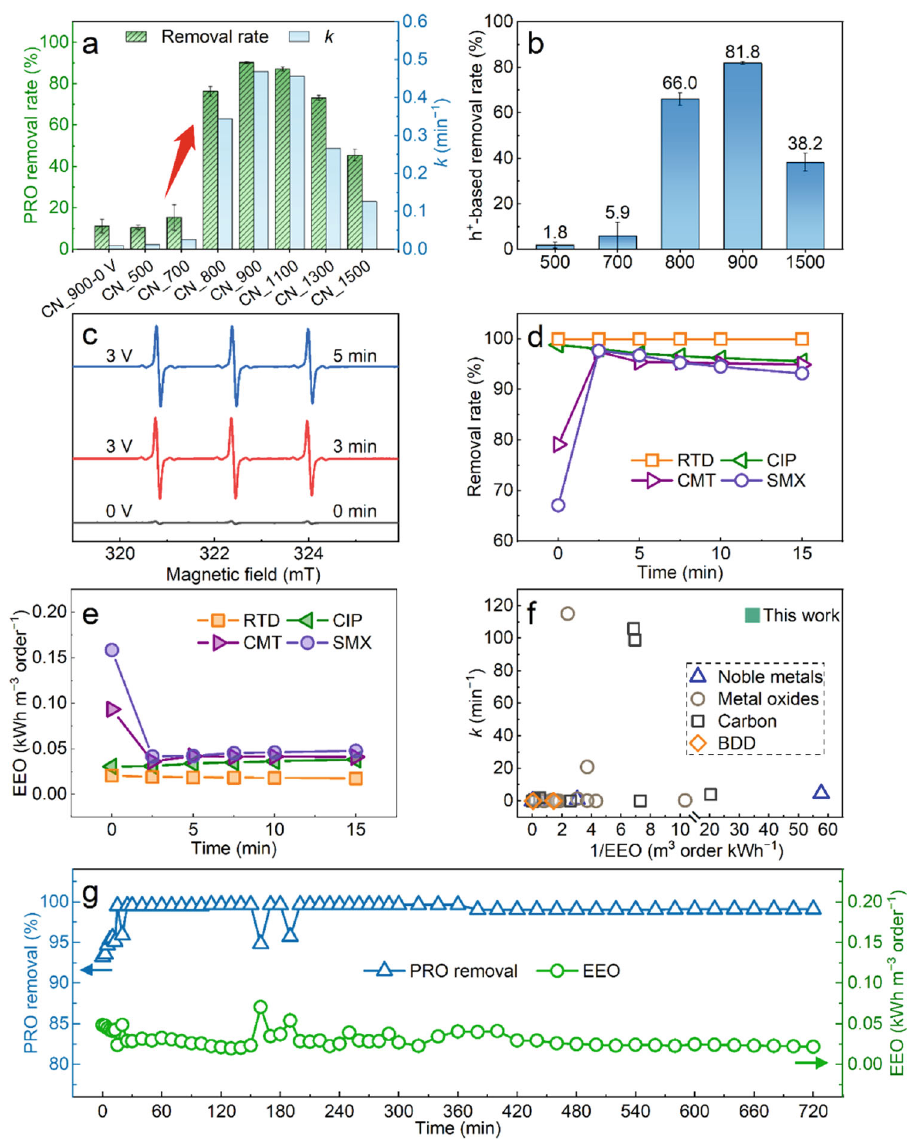
Fig. 6 | Facile thermal tuning effectively boosts electrocatalytic ef fi ciency. a ComparisonoftheelectrocatalyticperformanceintermsofthePROremovalrate (%)after5mintreatmentinabatch-modeEMFsystemandkineticdegradationrate constant( k ,min − 1 ,calculatedby fi ttingbasedonthedatainSupplementaryFig.13b) among the different CNmembranes. b Comparison of the calculated PRO removal rates owing to h + oxidation among the different CN membranes (more data in Supplementary Fig. 16 and 17). c ESR spectra demonstrating the presence of 1 O 2 using 100 mM 2,2,6,6 ‐ tetramethyl ‐ 4 ‐ piperidone (TEMP) as the trapping agent based on the CN_900 membrane. Universality evaluation of the performance of CN_900 in terms of ( d ) removal rate and ( e ) electrical energy per order (EEO) in